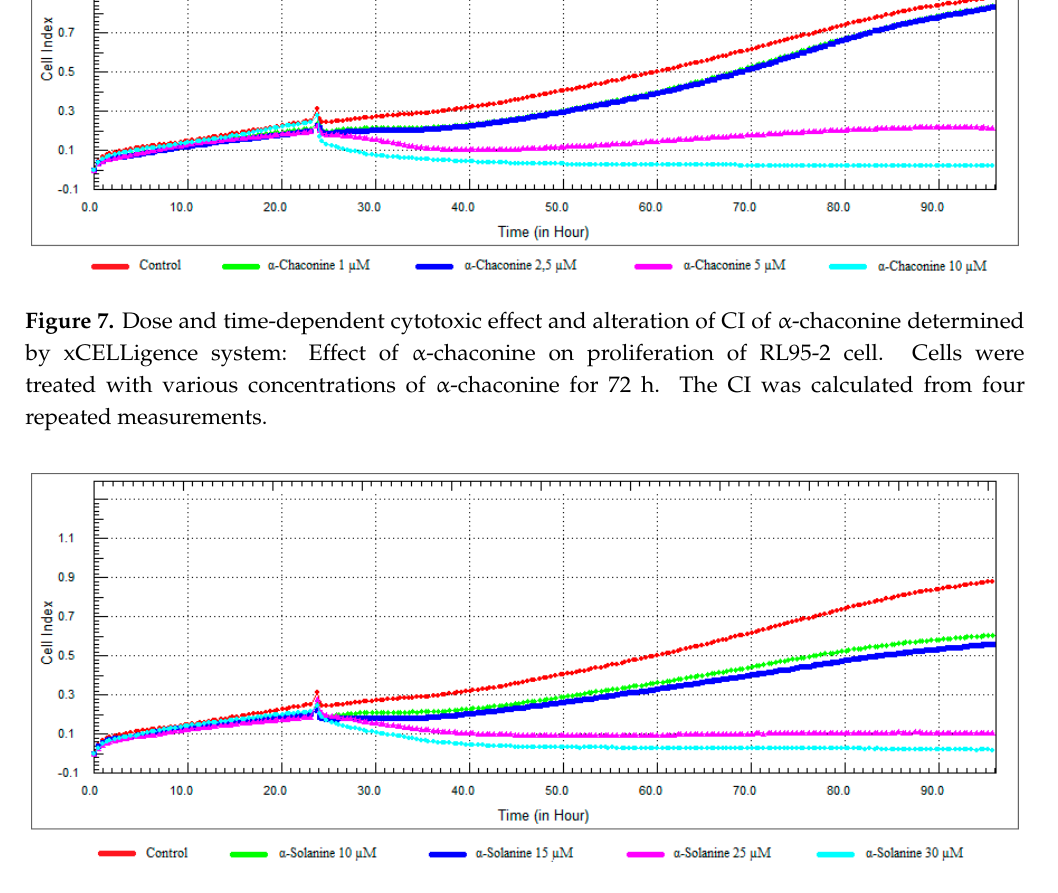
Figure 10. Dose and time-dependent cytotoxic effect and alteration of CI of API-1 determined by xCELLigence system: Effect of API-1 on proliferation of RL95-2 cell. Cells were treated with various concentrations of API-1 for 72 h. The CI was calculated from four repeated measurements. Table 1. IC 50 values of RL95-2 cells for 24 h 1 . Compound